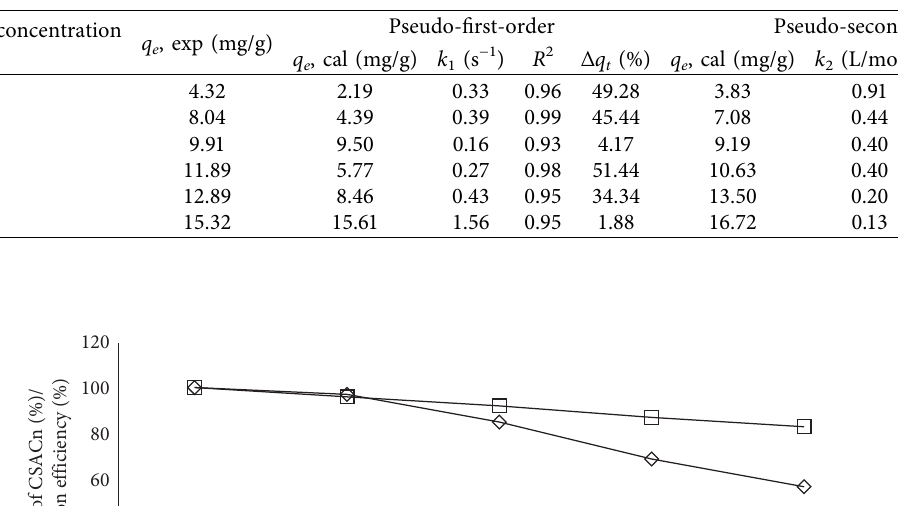
Figure 12: Linearized plots of (a) PFO and (b) PSO models for the DDT-CSAC system (solution temperature of 30 ° C, adsorbent dose of 0.2g, solution volume of 200mL, and solution pH of 7). Table 8: Kinetic parameters for the DDT-CSAC adsorption system at 30 °